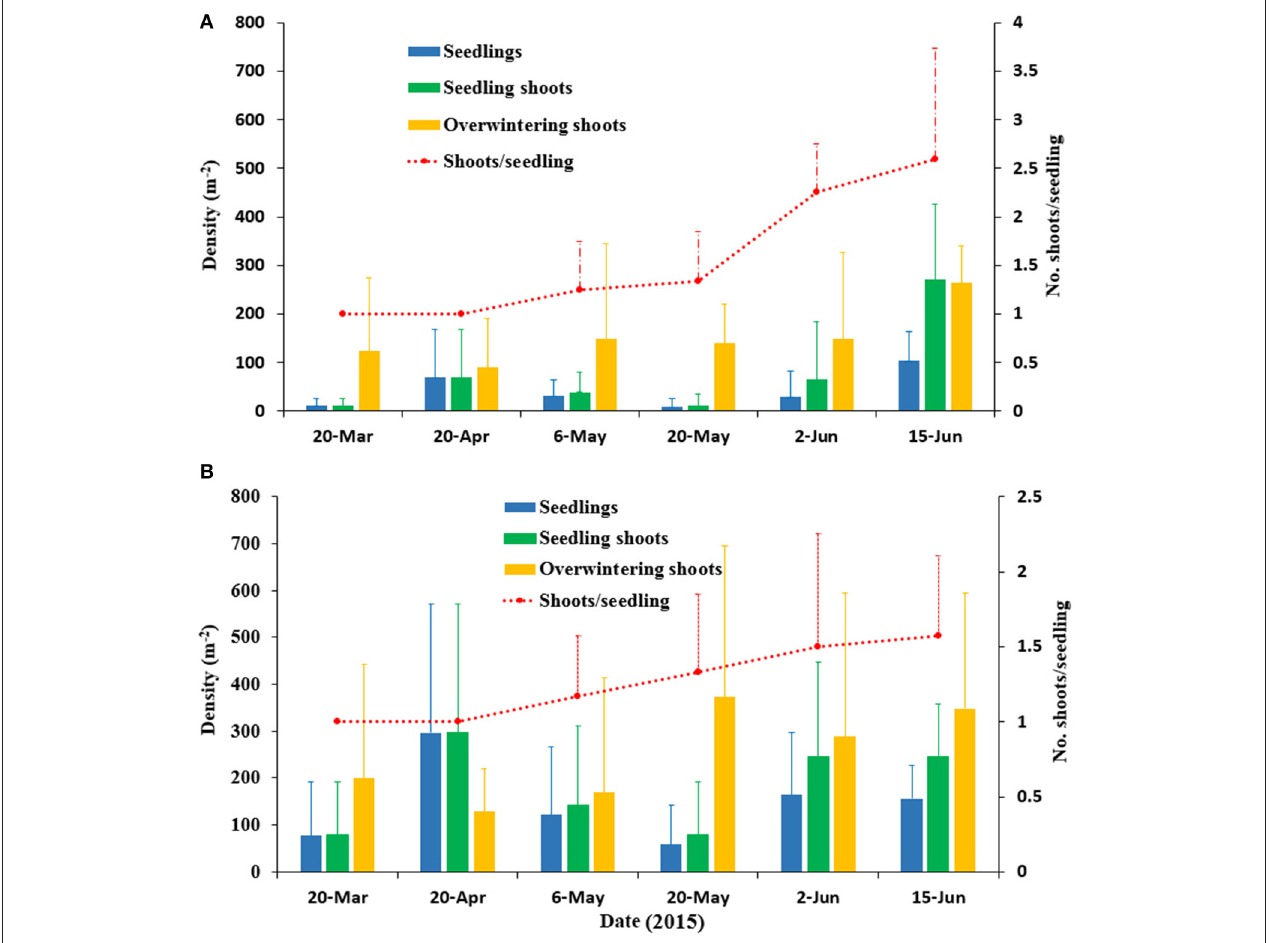
FIGURE 8 | Densities of seedlings, seedling shoots and overwintering shoots, and the number of shoots per seedling of Zostera marina at the patch site (A) and the center site (B) in Swan Lake in 2015. Values are means ± sd .